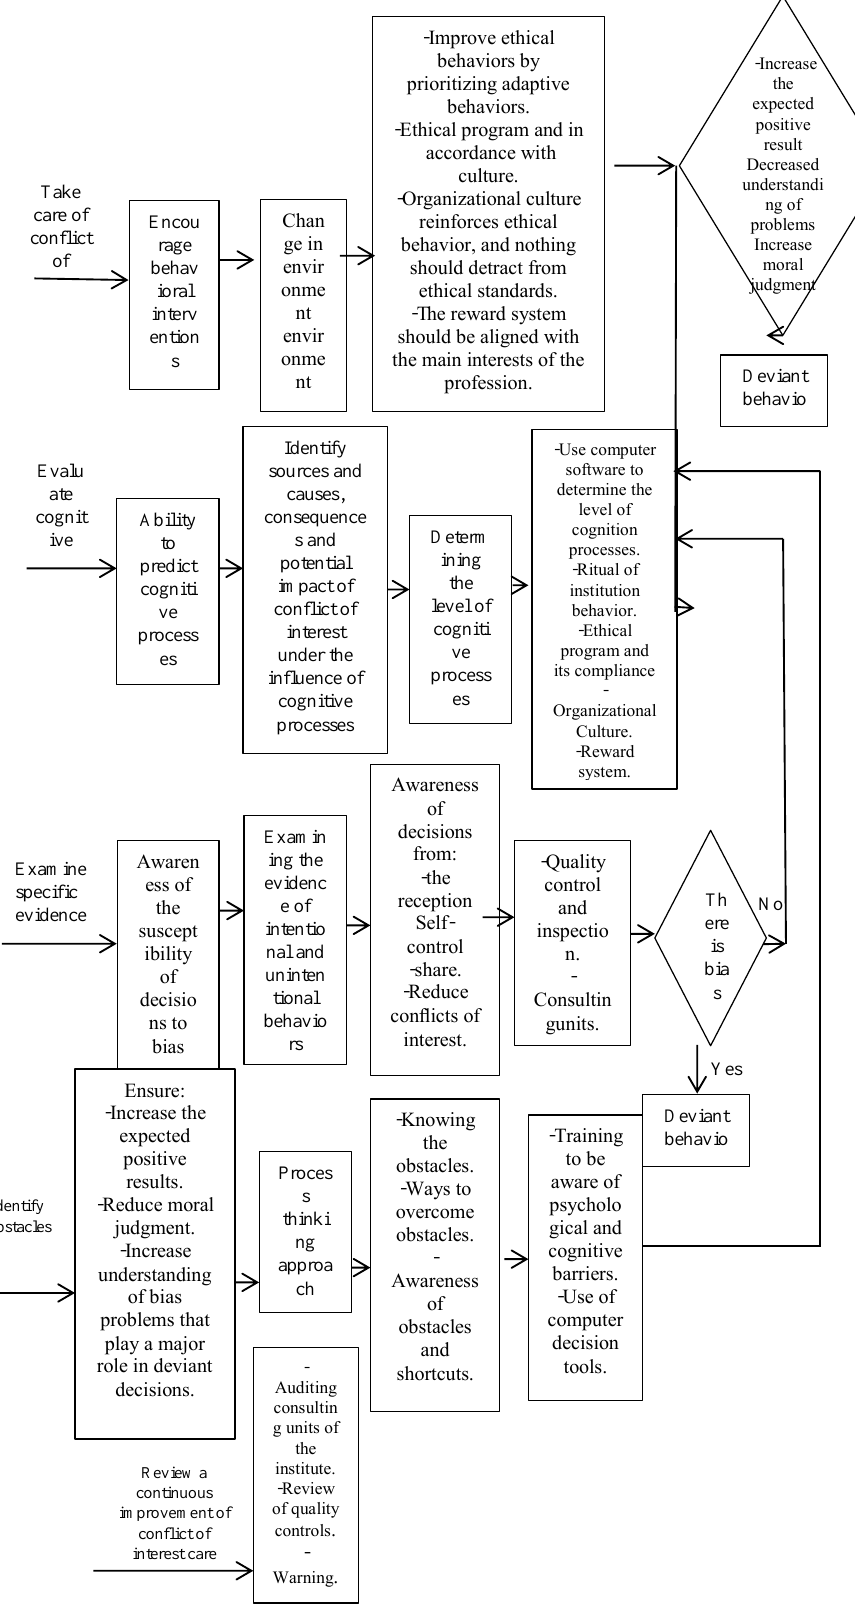
Figure 4. Proposed behavioral algorithm for conflict of interest